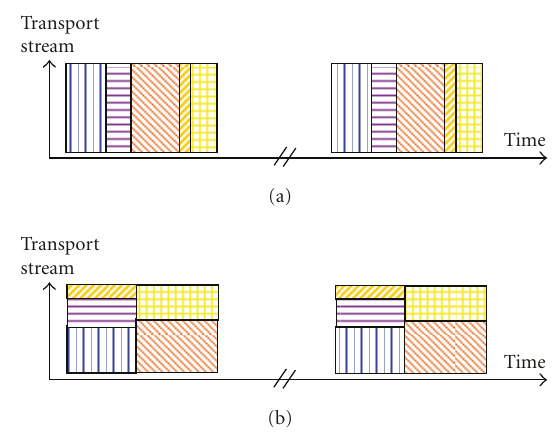
Figure 2: Consecutive (a) and parallel (b) transmission of di ff erent DVB-H services.